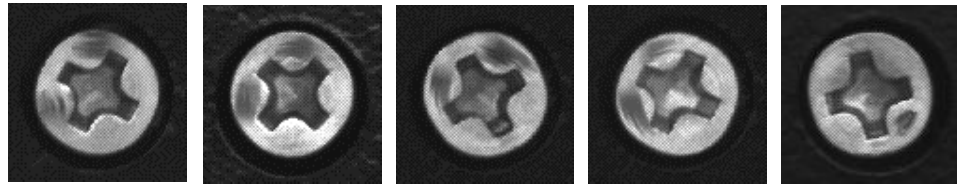
Figure 7. Surface dirty screws.